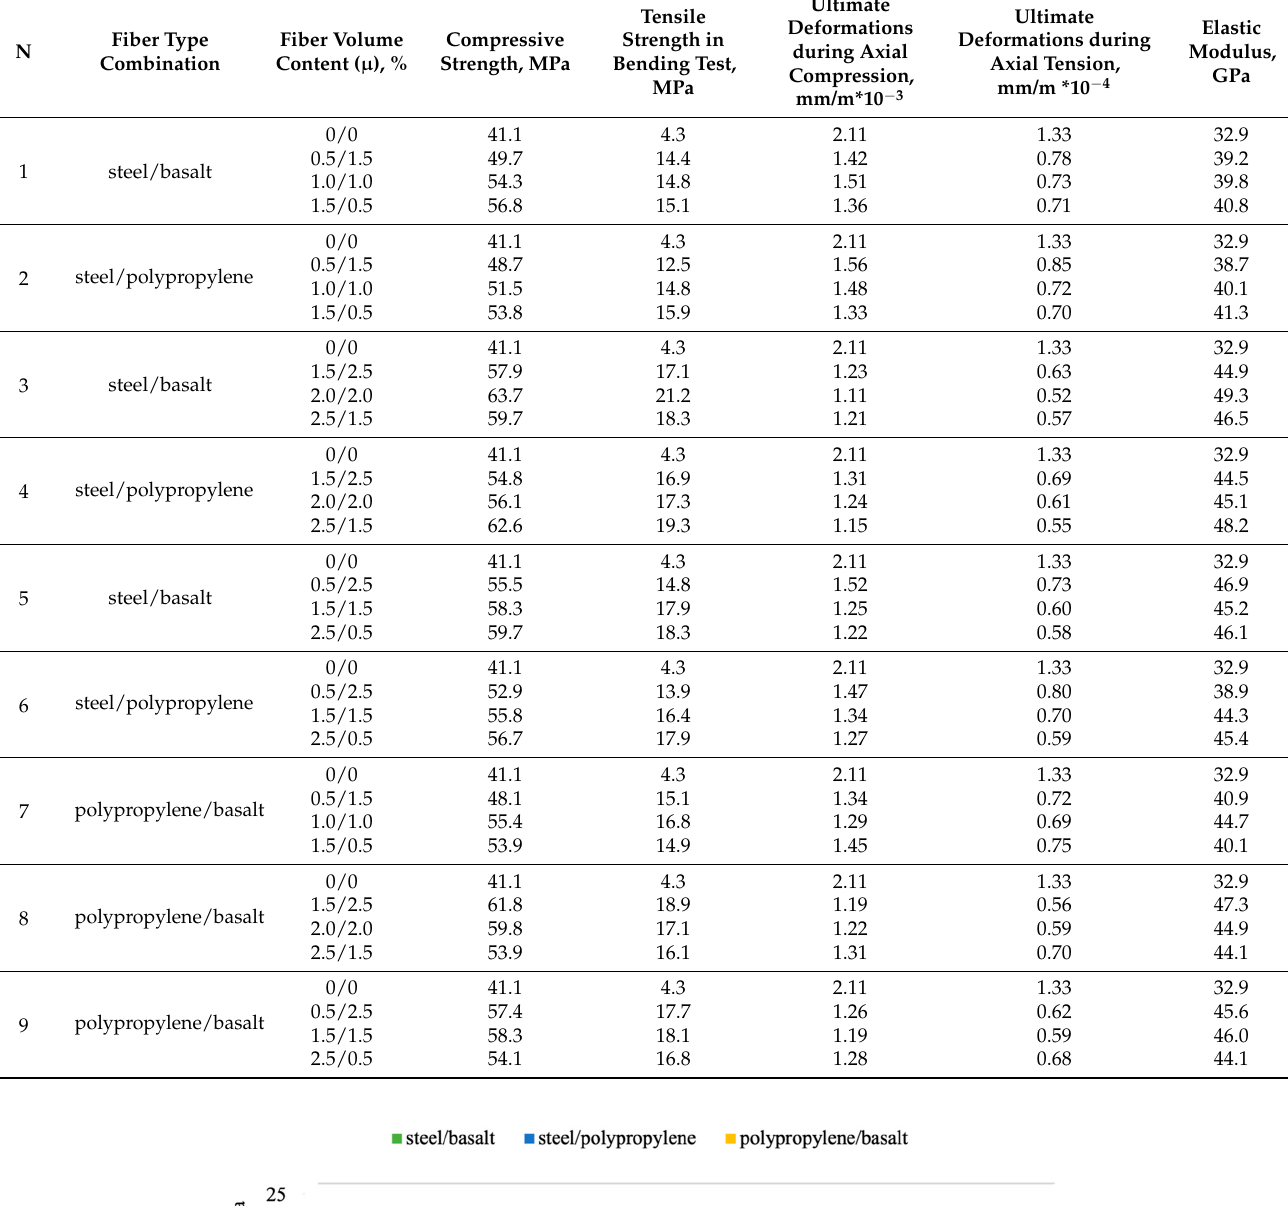
Table 8. Results of experimental studies of the effect of a combination of various types of fibers and volume content on the strength and deformation characteristics of fiber-reinforced concrete.